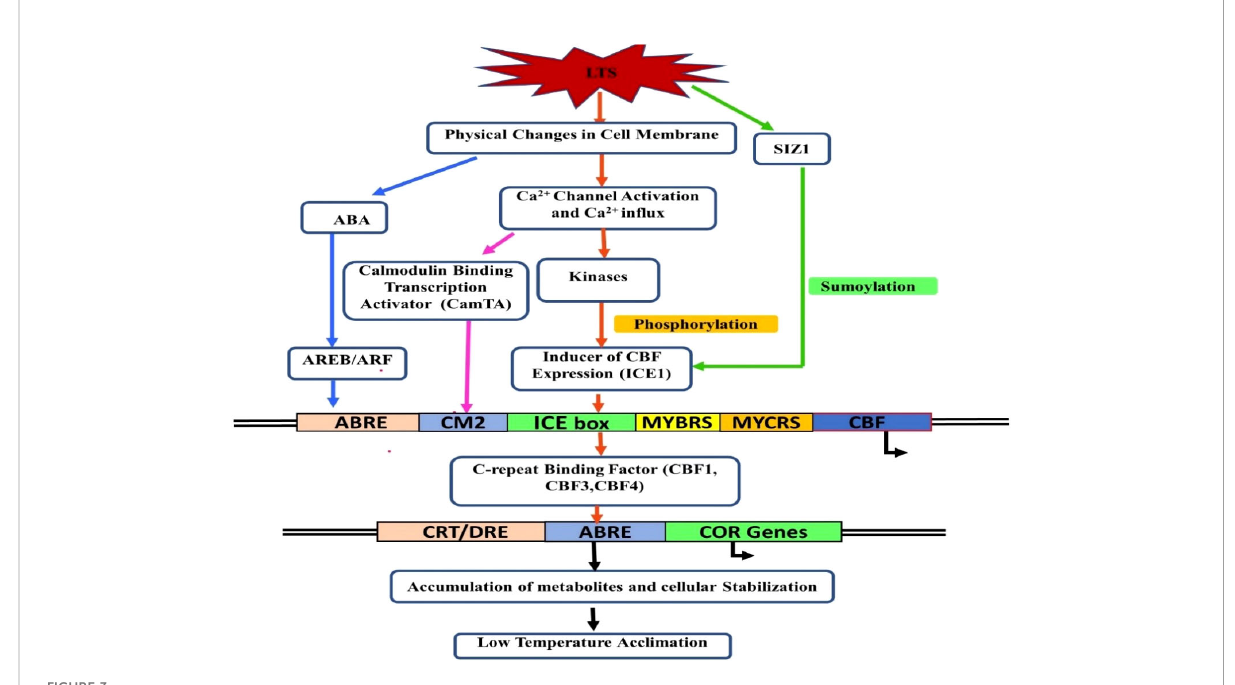
FIGURE 3 Signaling network for low-temperature stress acclimation in